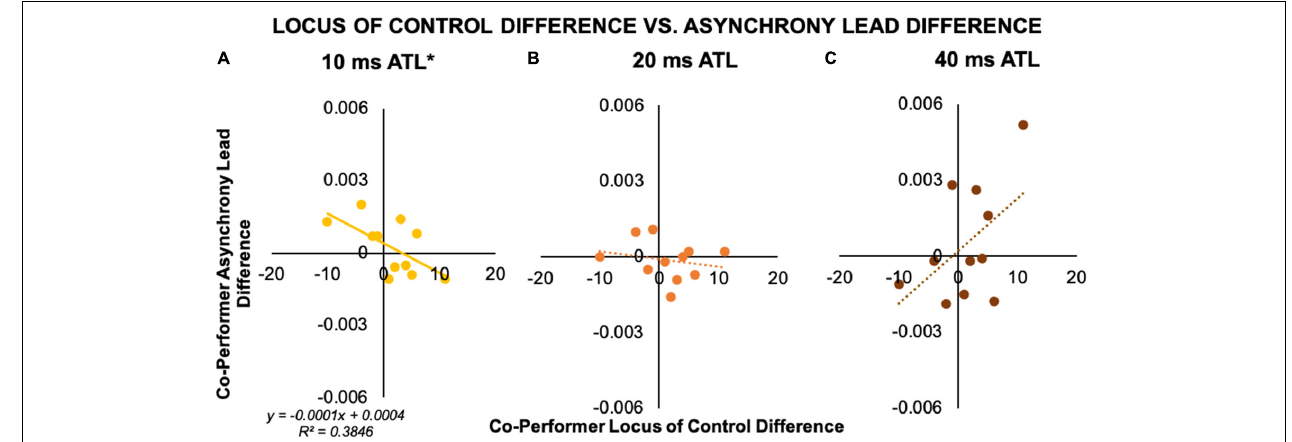
FIGURE 6 | Correlation of co-performer measures between asynchrony and locus of control score. (A) 10 ms ATL . Within a pair, the performer with a more internal locus of control exhibited more anticipatory behavior than their co-performer in the 10 ms ATL condition. (B) 20 ms ATL . There was no association between within-pair differences in locus of control and asynchrony lead in the 20 ms ATL condition. (C) 40 ms ATL . There was a trending positive association in the 40 ms ATL condition, with relatively less anticipatory behavior by the co-performer with the more internal locus of control. * p < 0.05.